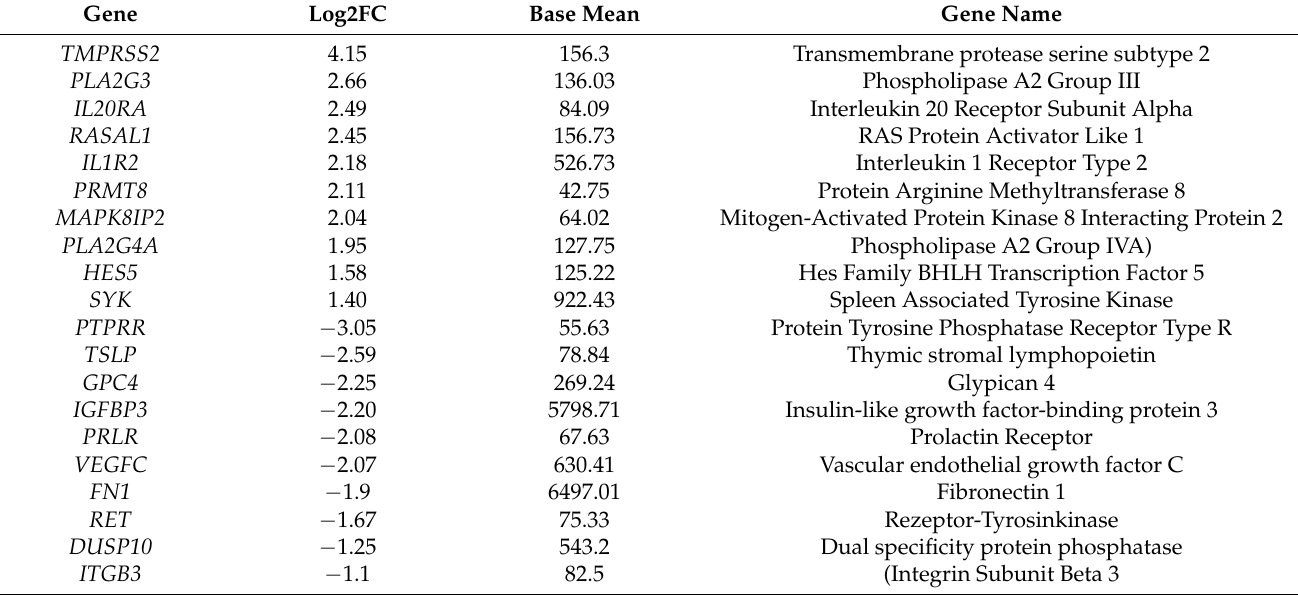
Table 2. Significant differentially expressed genes between the two clusters within the TP53mut cohort, p < 0.001, +log2fold change higher gene expression in group 2 vs. group1. − log2fold change: lower gene expression in group 2 vs. group